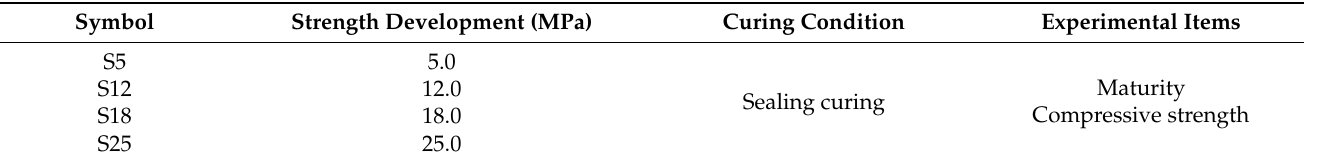
Table 3. Experimental design of